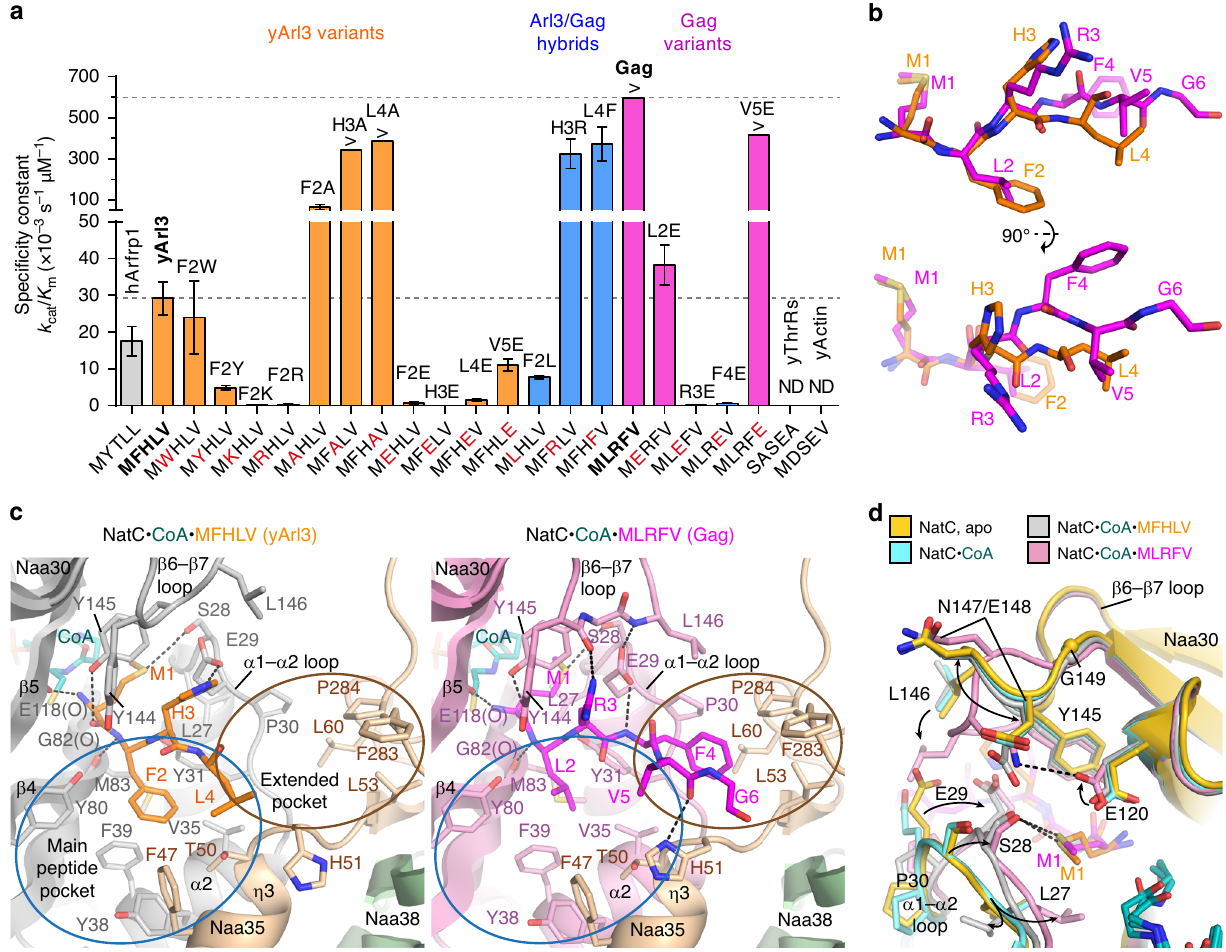
Fig. 3 NatC substrate recognition. a Speci fi city constants of NatC WT toward various decameric substrate peptides. The N-terminal fi ve residues are shown, with all peptides ending on -GSRRR. Data represent means ± SD calculated from k cat and K m values of independent experiments considering the propagation of uncertainty. The number of repetitions is provided in Table 2. Four peptides exhibited K m values below the detection limit of the colorimetric assay and were assumed to be <20 µ M (Supplementary Fig. 6). Thus, the bar graphs for these peptides (marked with “ > ” ) represent the lower bound of the speci fi city constant and no error bar is provided. b Substrate peptides in the NatC • CoA • MFHLV (orange) and NatC • CoA • MLRFV (magenta) structures. c Magni fi ed views into the active sites of the two peptide-bound NatC complexes, shown in the same orientation. Hydrogen bonds are indicated as black dashed lines. d Superposition of all four NatC structures focusing on structural changes in the α 1 – α 2 and β 6 – β 7 loop in